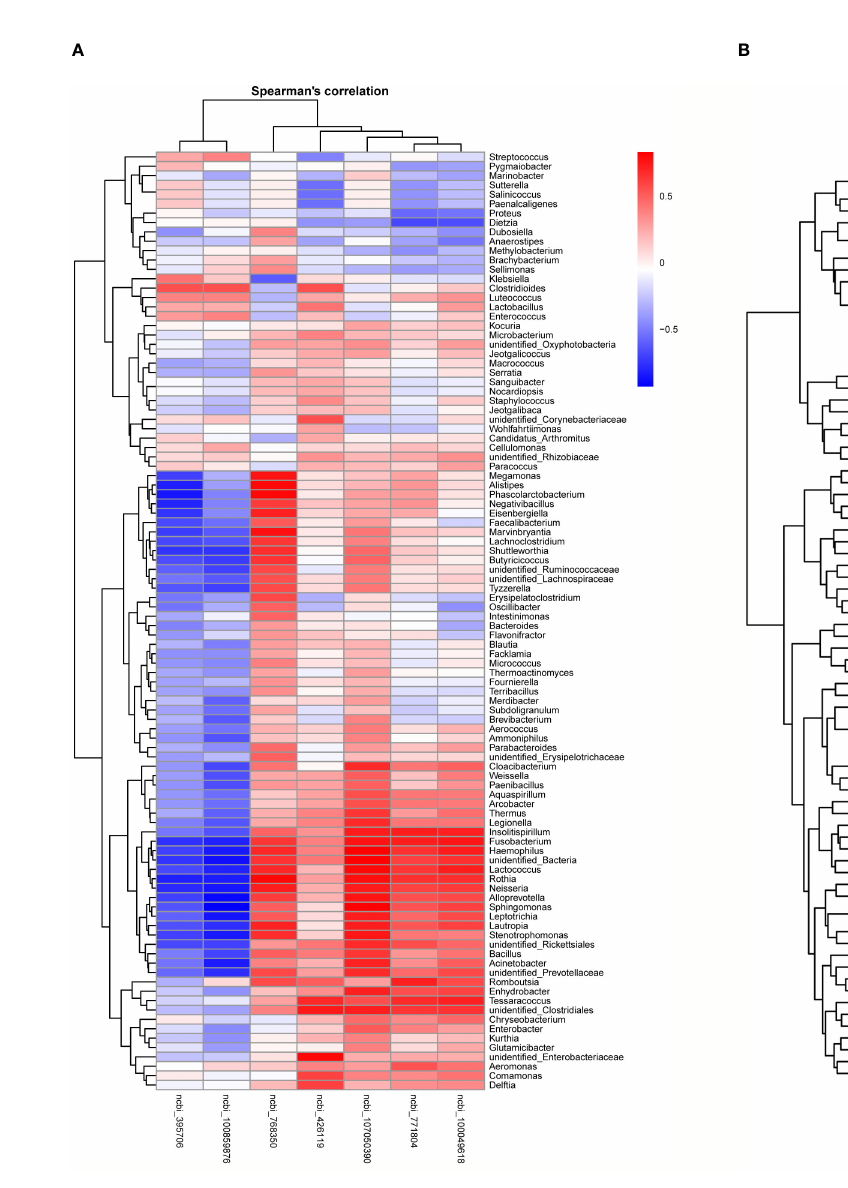
FIGURE 11 | Heatmaps of Spearman correlation analyses between the abundance of top 100 bacterial genera and two metabolic and three immune genes in the ileum (A) and the cecum (B)